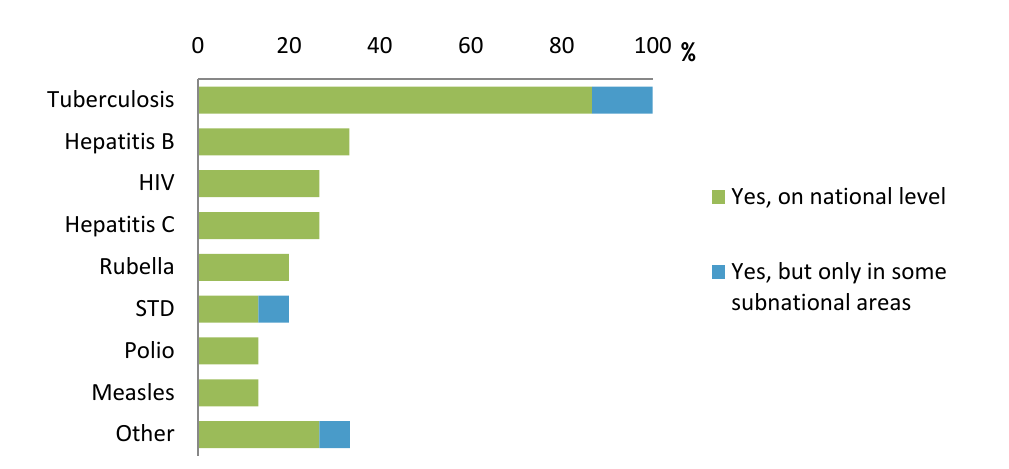
Figure 1. Infectious diseases screened for in countries with implemented screening programmes ( n =